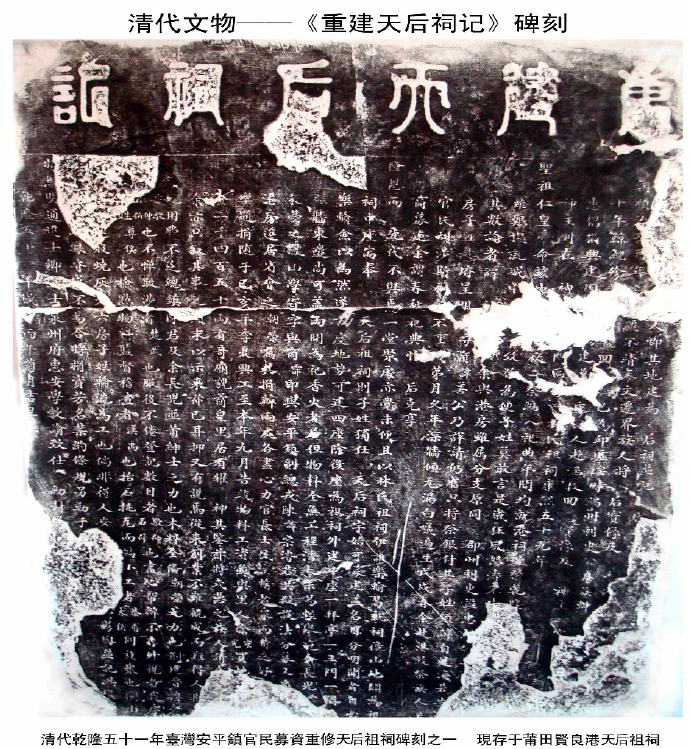
Figure 2. The inscription, “Record of Reestablishing Ancestral Hall of the Celestial Empress” ( Chongjian tianhou ciji , 1786). Preserved in The Ancestral Hall of the Celestial Empress at Xianliang Port (Xianliang gang tianhou zuci). Source: The website of Xianliang gang zuci, http://www.mzdsd.org/mazu/40283.html.